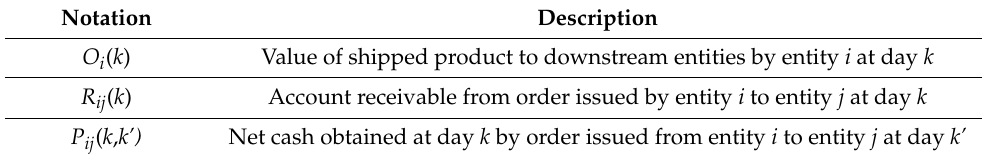
Table 3. External input variables.